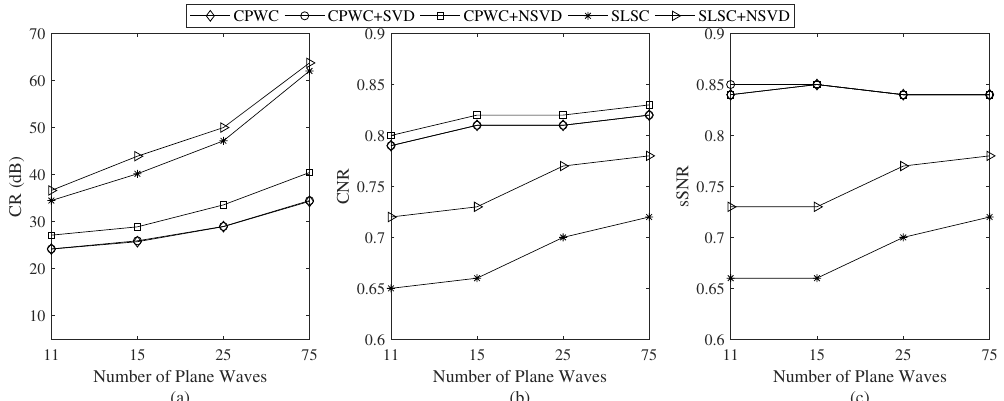
Figure 21. Effect of the number of compounding angles on ( a ) CR, ( b ) CNR, and ( c ) sSNR in in vivo